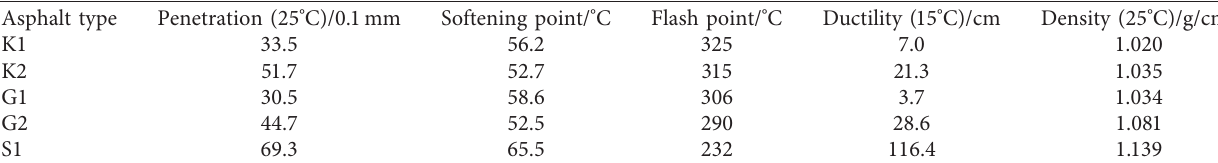
Table 1: Properties of